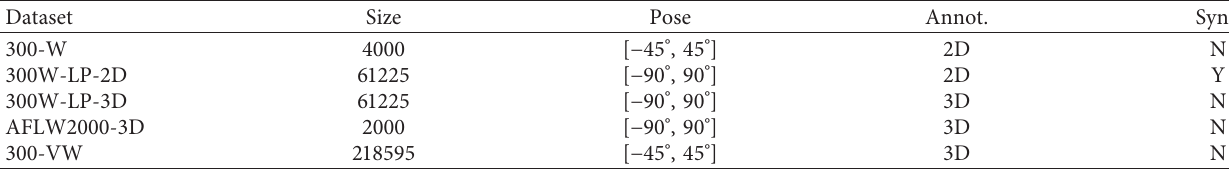
Table 1: The main features of image dataset.